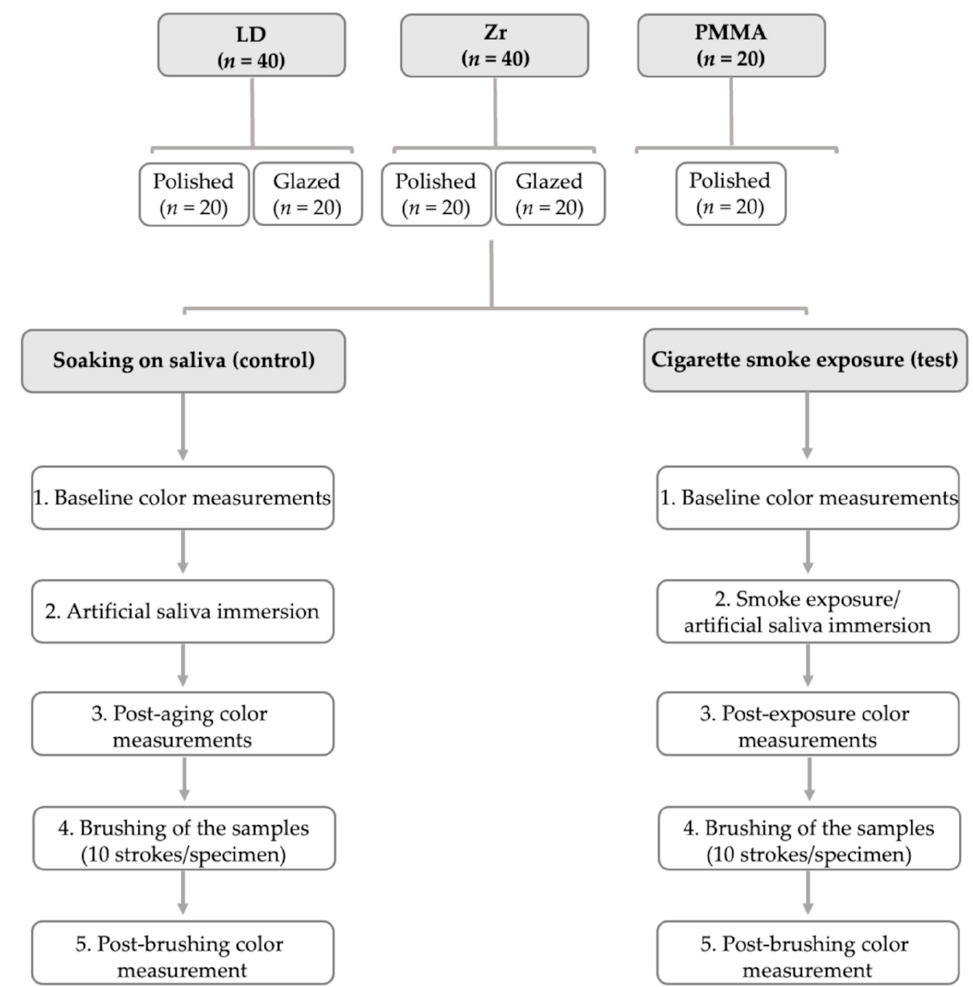
Figure 2. Schematic diagram of the experimental design. Lithium disilicate (LD), zirconia (Zr), and Telio PMMA (PMMA).